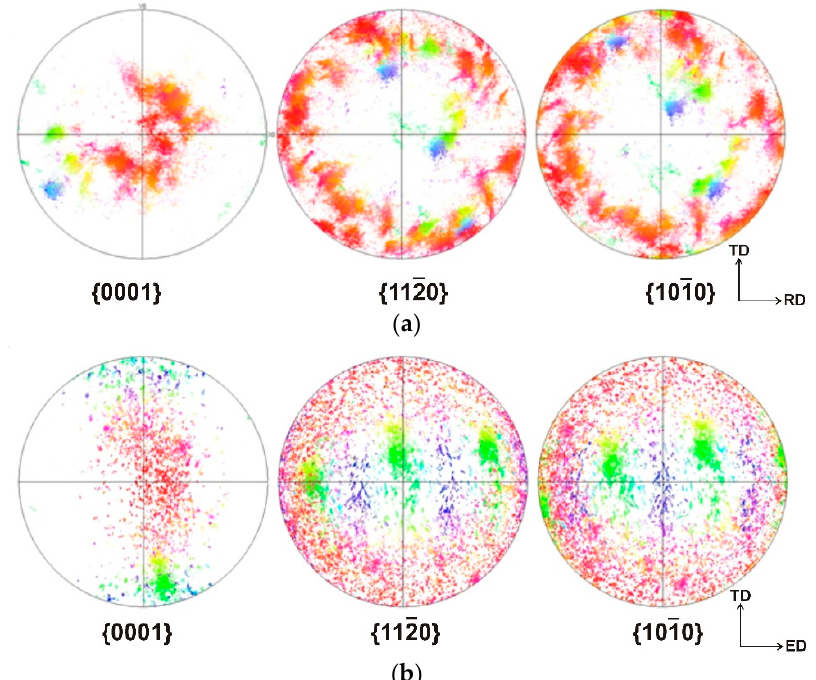
Figure 4. Pole figures of ( a ) rolled Mg samples (rolling direction RD, right; transverse direction TD, top; normal direction ND, projection plane) and ( b ) extruded Mg samples (extrusion direction ED, right; transverse direction TD, top; normal direction ND, projection plane).